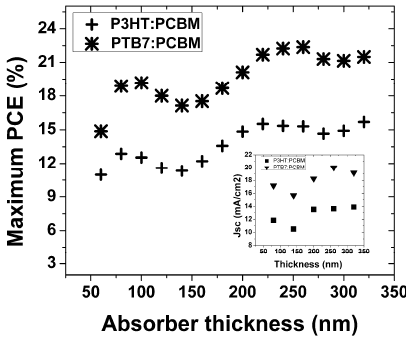
Figure 2. The final PCE estimation of conventional solar cells based on P3HT:PC 60 BM and PTB7:PC 70 BM active layers for nominal (1.2 eV) fixed band gap (inset: J sc vs. active layer thickness). J sc : short circuit current.